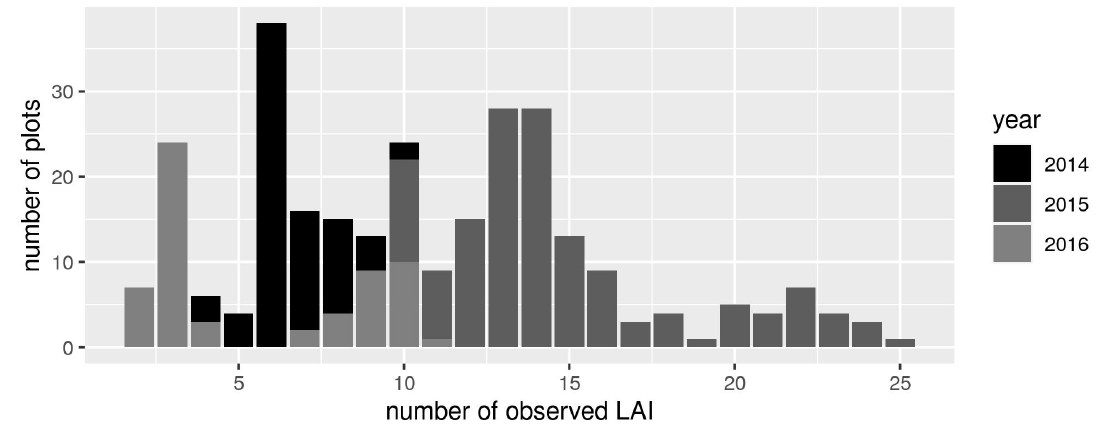
Figure 3. The 281 plots of the field network distributed according to the year and the number of available LAI observations during the period